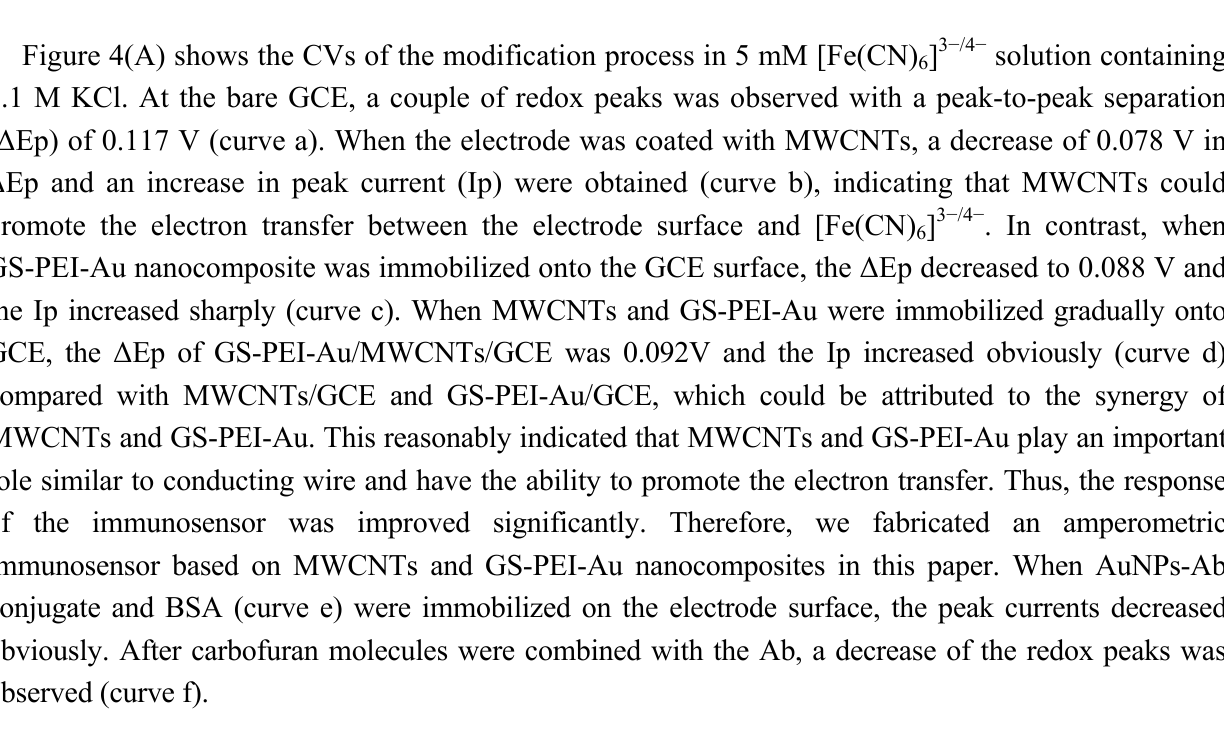
Figure 4. CVs of ( A ): (a) bare GCE, (b) MWCNTs/GCE, (c)